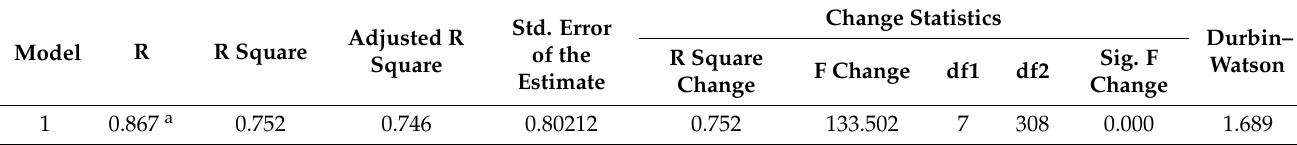
Table 5. Model summary b .